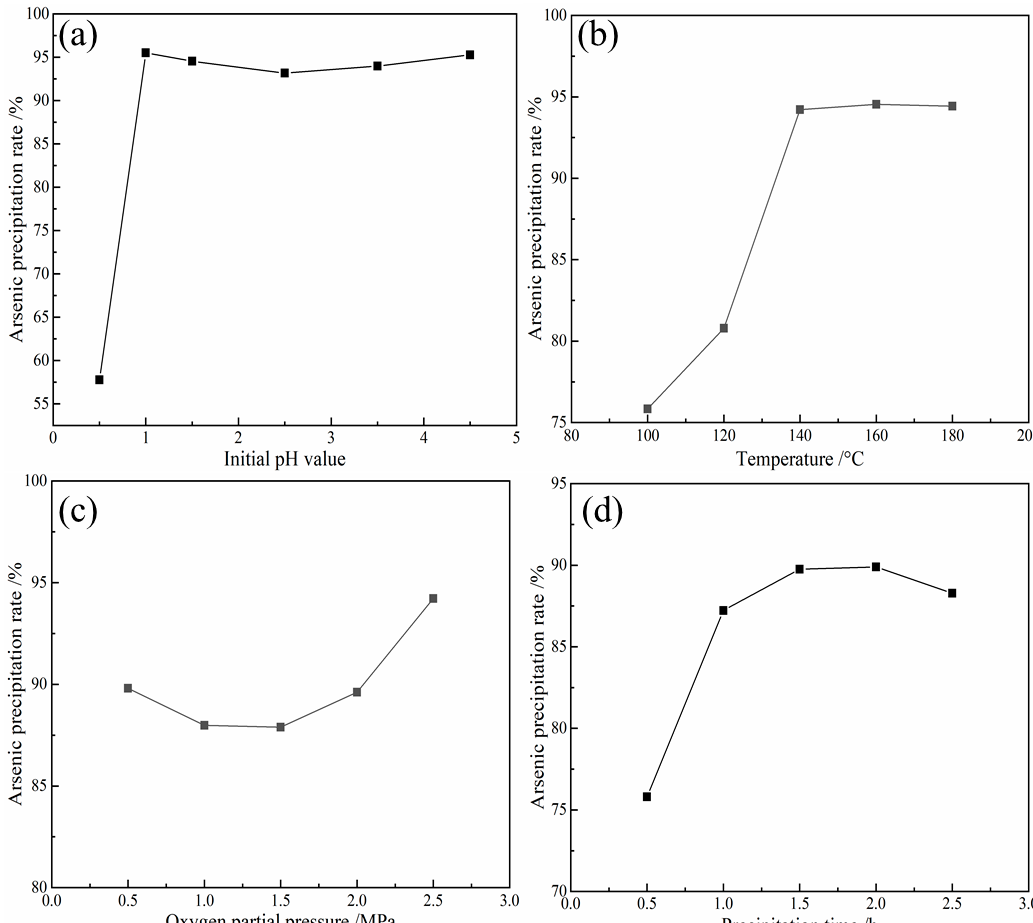
Figure 8. Effects of different precipitation conditions on arsenic precipitation rate: ( a ) initial pH, ( b ) temperature, ( c ) p O 2 , ( d ) precipitation time.